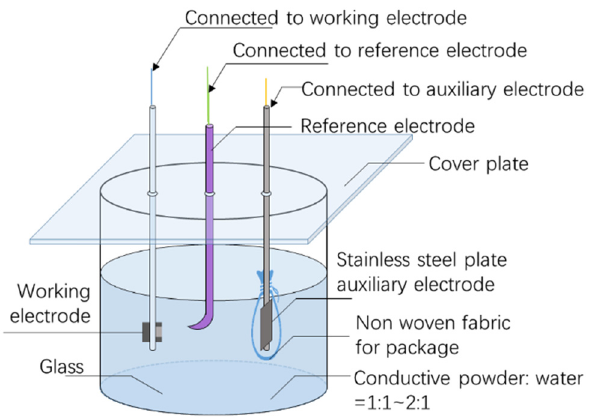
Figure 3: Schematic diagram of a three - electrode system test